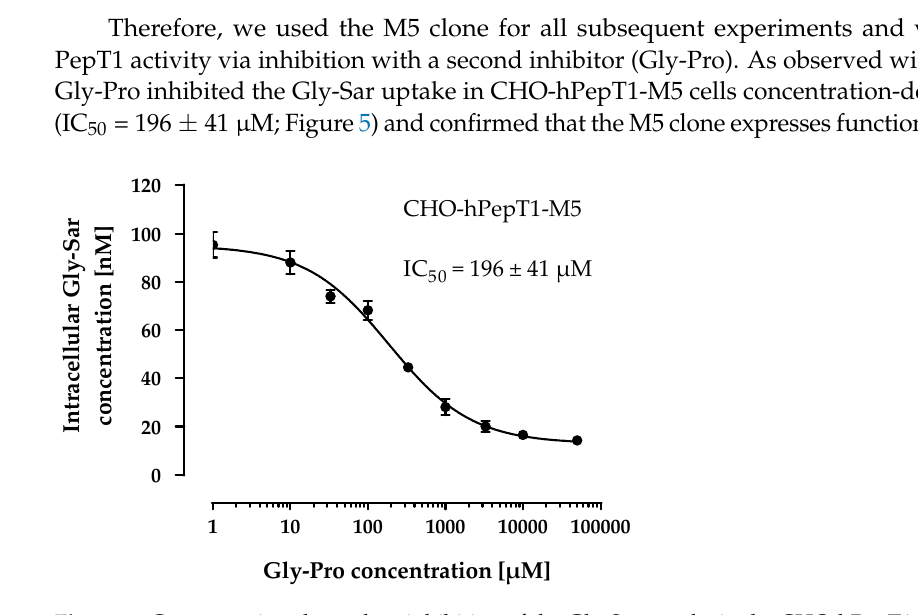
Figure 4. Concentration-dependent inhibition of the Gly-Sar uptake in the CHO-hPepT1-M5 ( a ) and the CHO-hPepT1-200 ( b ) clone by losartan. The data points represent the mean ± S.E.M. of three independent experiments with each concentration tested in sextuplets.